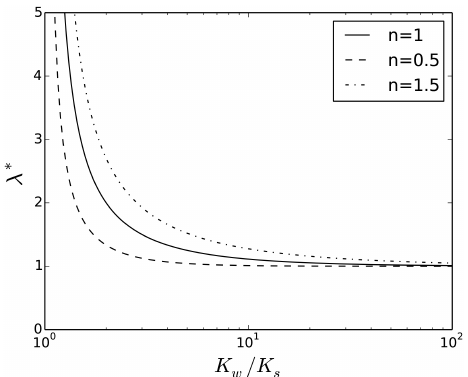
Figure 8. The dimensionless damping length scale, λ ∗ , as a func- tion of erodibility ratio. Damping of base-level perturbations is strong when the erodibility ratio is greater than 3. λ ∗ can be in- terpreted as roughly the number of pairs of strong and weak rock layers that base-level perturbations must pass through before sub- stantial damping toward continuity steady state.